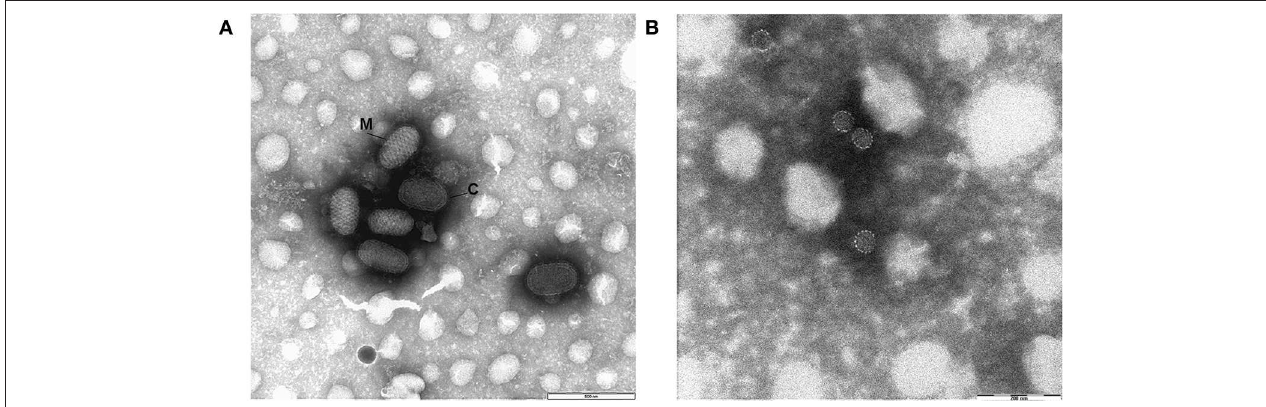
FIGURE 2 | Negative-staining EM micrographs of (A) Parapoxvirus showing the typical morphology: oblong, rounded, or ovoid large particles of around 140–170nm wide and 220–300nm long. M (mulberry) form, C (capsule) form. Bar = 500nm. (B) Papillomavirus: non-enveloped icosahedral particles of around 50–55nm in diameter. Bar =